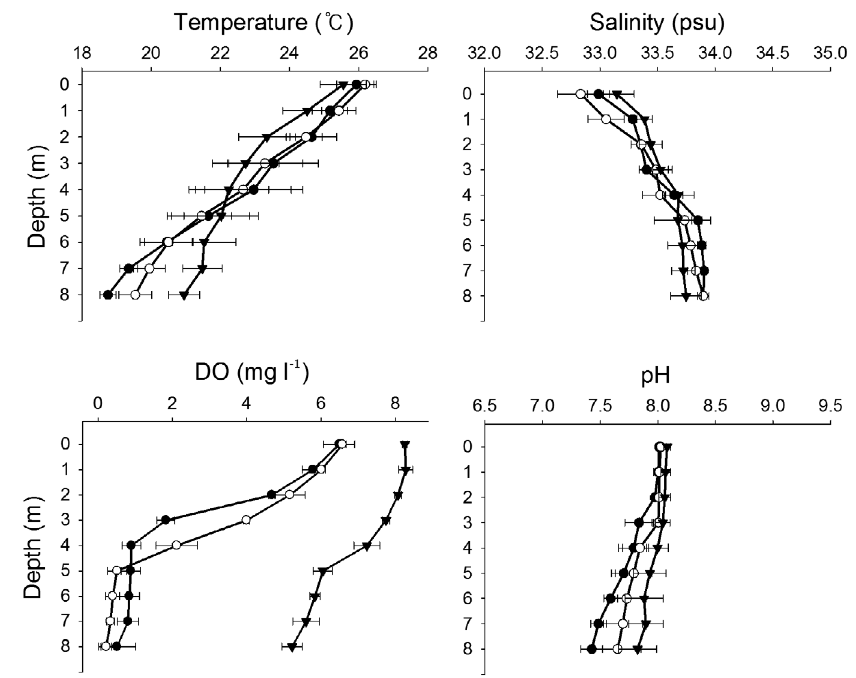
Fig. 2. Vertical profiles of the major environmental variables examined at the study sites during oxycline persistence. Solid circle: hypoxic site 1 (HS-1); empty circle: hypoxic site 2 (HS-2); solid triangle: reference site (RS). Data are means ±